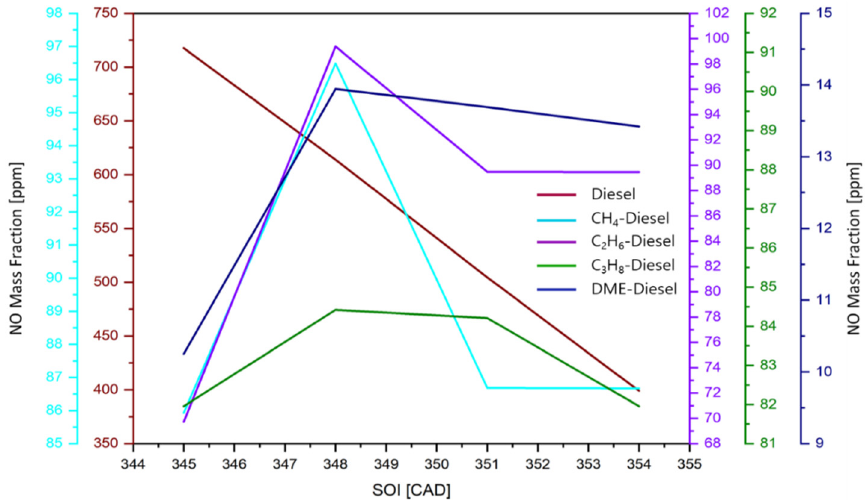
Figure 25. Synthetic of NO mass fractions according to pilot SOI angles in all combustion modes